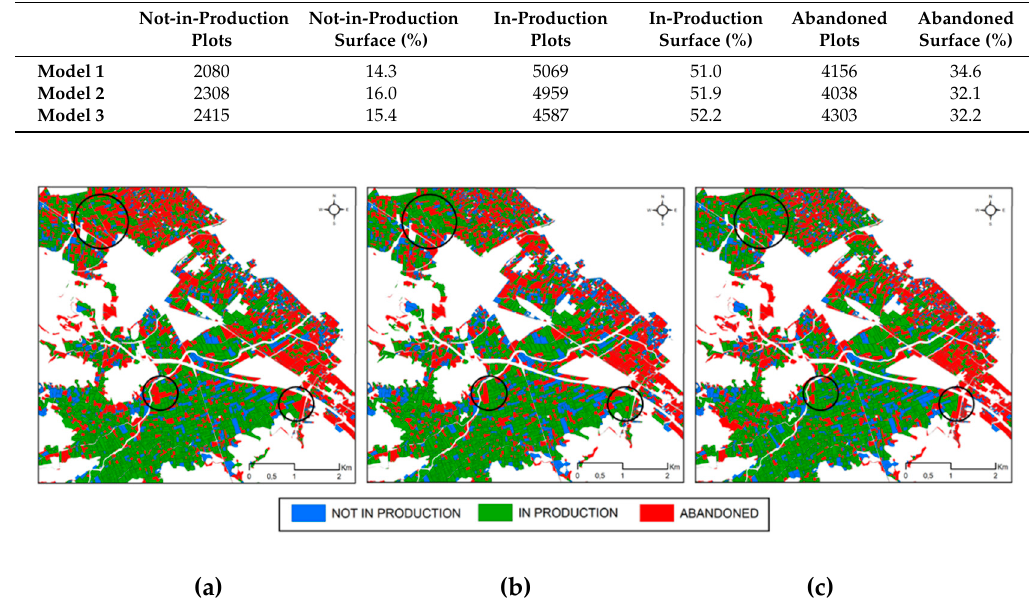
Figure 6. Land abandonment map generated by each model. Model 1 ( a ), Model 2 ( b ) and Model 3 ( c ). The circles show areas where the models predicted differently.